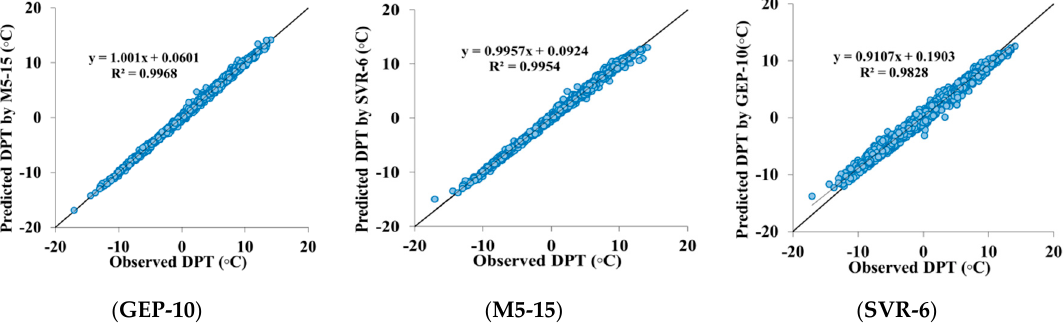
Figure 5. The scatter plots of observed and estimated DPT values with most precise models including ( GEP-10 ), ( M5-15 ), and ( SVR-6 ).